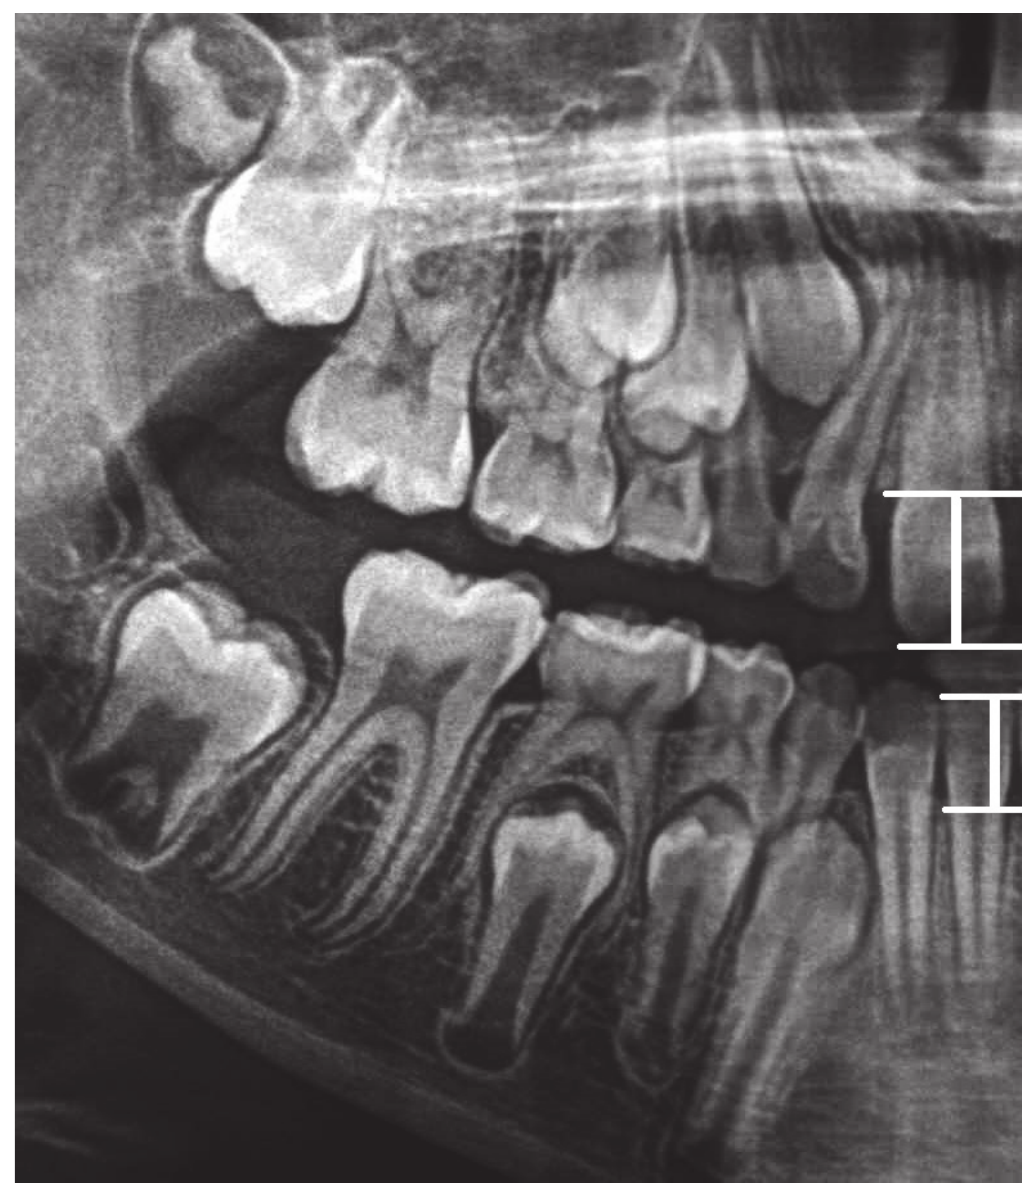
Figure 2. Graphic representation of the S11-W11 and S 41-W41 distances. S12-W12 is the distance between point S12 (on the incisal margin of tooth 12) from point W12 (the point on the alveolar margin in the line drawn through the point on top of the alveolus perpendicular to the X